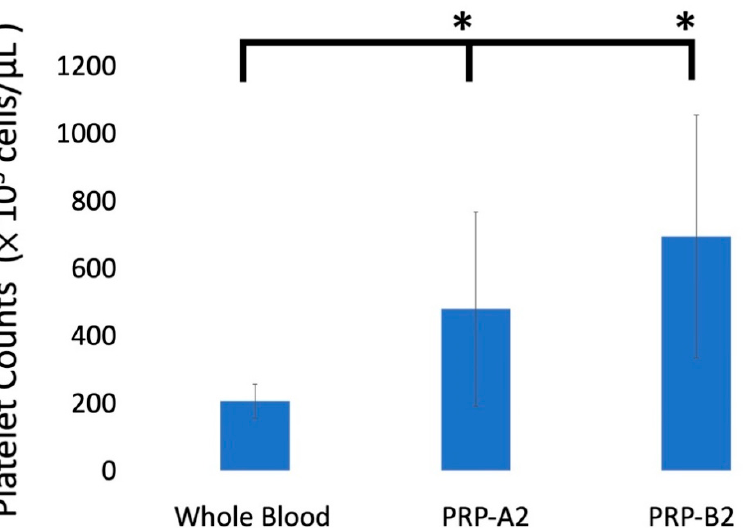
Figure 1. The platelet concentrations after two types of PRP preparations. The platelet concentrations were significantly higher than those of whole blood. * p -value < 0.05. Error bars showed mean ± standard deviation. Table 1. Demographic data of the blood content from 19